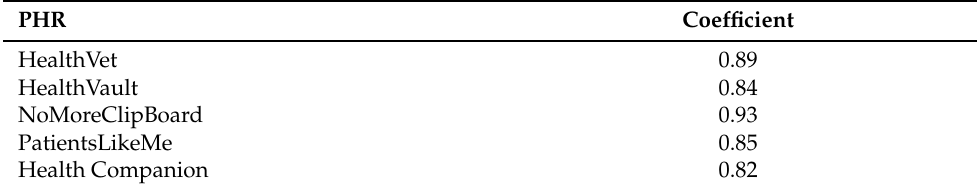
Table 4. The Split-Half Reliability